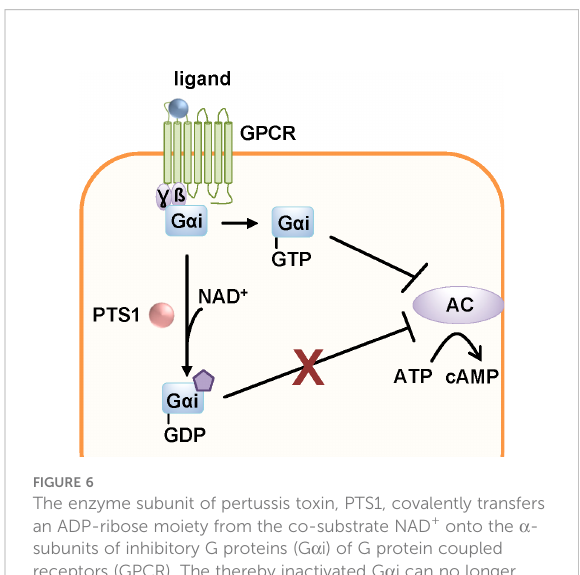
FIGURE 6 The enzyme subunit of pertussis toxin, PTS1, covalently transfers an ADP-ribose moiety from the co-substrate NAD + onto the a - subunits of inhibitory G proteins (G a i) of G protein coupled receptors (GPCR). The thereby inactivated G a i can no longer down-regulate the adenylate cyclase (AC) upon GPCR activation. This leads to disturbed cAMP signaling (Locht et al.,